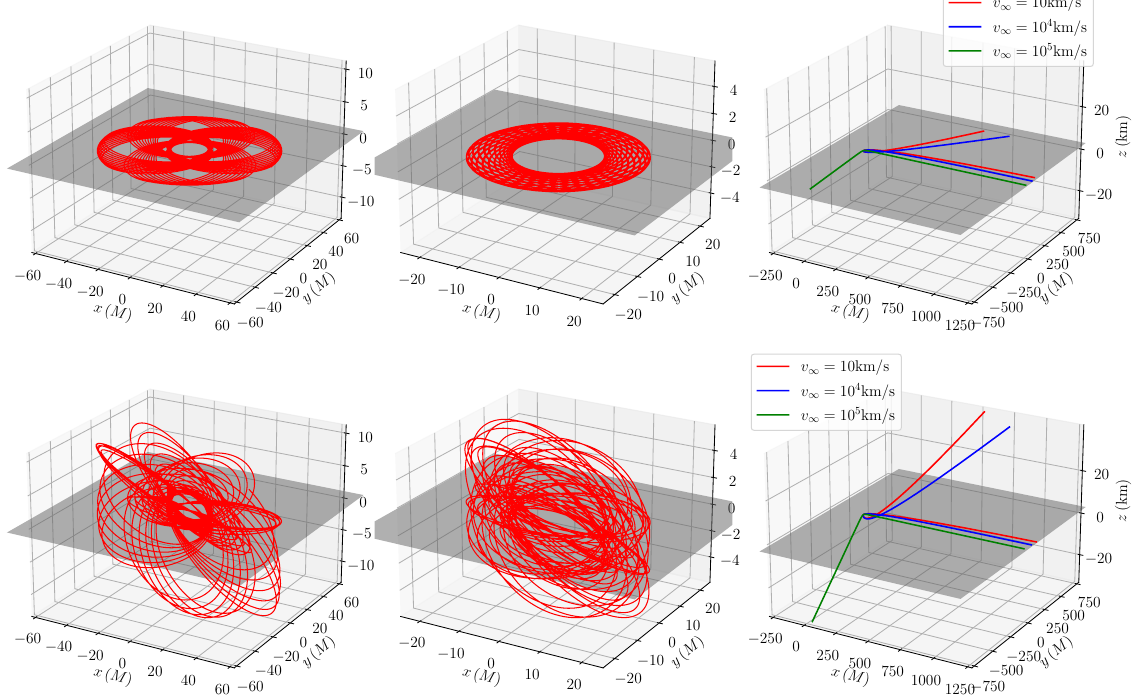
Figure 5. Comparison of the elliptical ( left and middle panels ) and hyperbolic orbits ( right panels ) of a 1-msMSP in the vicinity of a 10 6 -M Schwarzschild BH, in the absence of spin coupling ( λ = 0 (cid:12) and C Q = 0, top panels ) and in the presence of quadrupole-order spin coupling ( λ = 0 and C Q = 6, bottom panels ). For the elliptical orbits, 50 cycles were shown. The maximum orbital distances to the BH are about 50 M and 20 M ( left and middle panels , respectively), and the minimum distances to the BH are about 10 M (for all cases regardless of the orbits being elliptical or hyperbolic. Cases for three initial speeds, of 10km s − 1 , 10 4 km s − 1 and 10 5 km s − 1 are shown. The plots are provided by Kaye Jiale Li